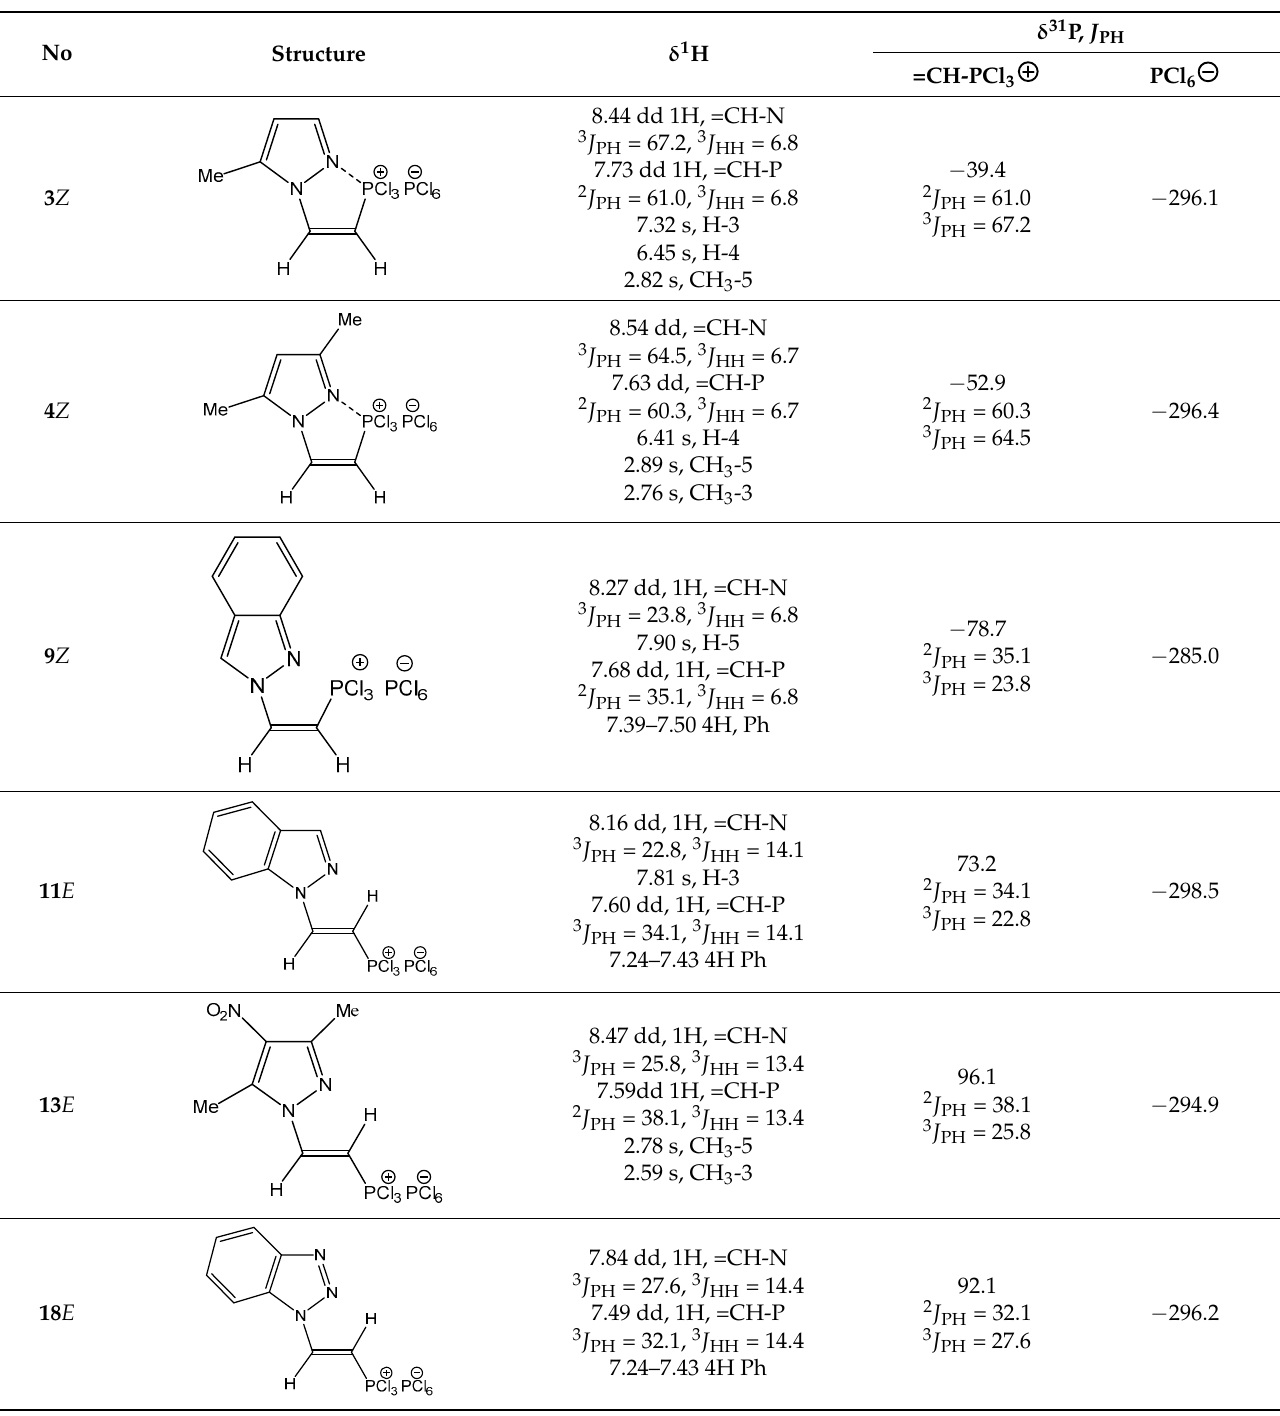
Table 2. The 1 H and 31 P NMR chemical shifts ( δ , ppm) and coupling constants ( J , Hz) of hexa- chlorophosphorates 1 – 4 , 9 , 11 , 13 , 18 .